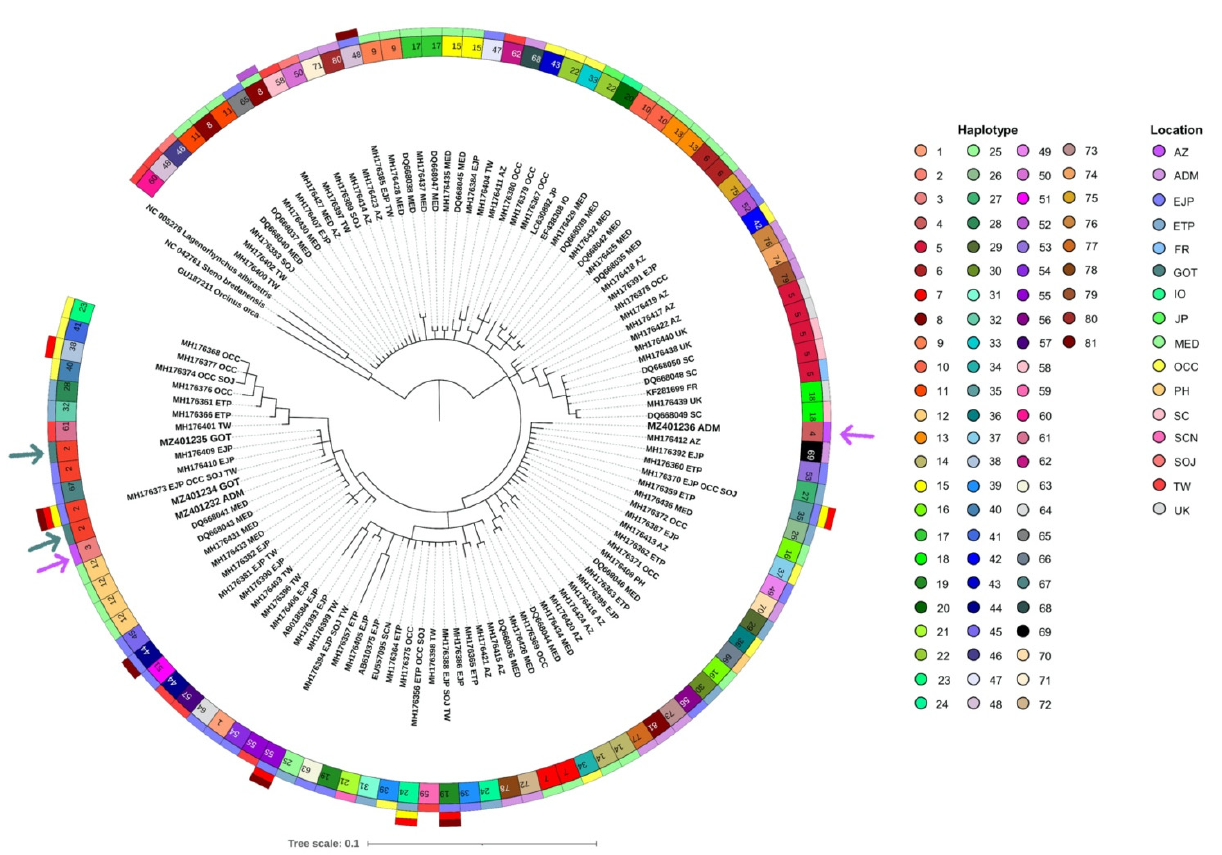
Figure 5. Bayesian phylogenetic tree of Risso’s dolphin based on 390 bp alignment of mitochondrial DNA control region. Accordingly, 96 sequences of Risso’s dolphins were acquired from the NCBI database, while four sequences were obtained from this study. The white-beaked dolphin ( Lagenorhynchus albirostris AJ554061), rough-tooth dolphin ( Steno bredanensis NC 042716), and killer whale ( Orcinus orca NC 023889) were utilized as out groups. The circular bands of color around the tree indicate haplotype: first layer and location, second, third, fourth, and fifth layers (inner to outer). Purple arrows indicate samples from the Thai Andaman Sea and green arrows indicate samples from the Gulf of Thailand. Abbreviations of location are as the follows: AZ, Azores Island; MED, Mediterranean; FR, France; SC, Scotland; UK, United Kingdom; IO, Indian Ocean; ADM, Thai Andaman Sea; GOT, Gulf of Thailand; PH, Philippines; TW, Taiwan; SCN, Southeastern China Sea; SOJ, Sea of Japan; JP, Japan; EJP, Eastern Japan; ETP, Eastern Tropical Pacific Ocean; OCC, Oregon-California Coastal.